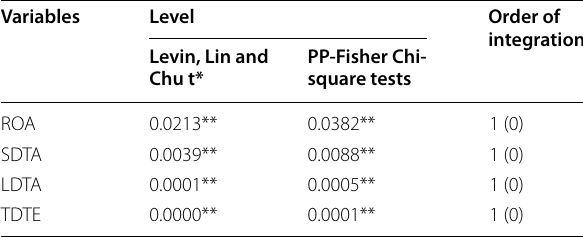
Source: Author’s Computation